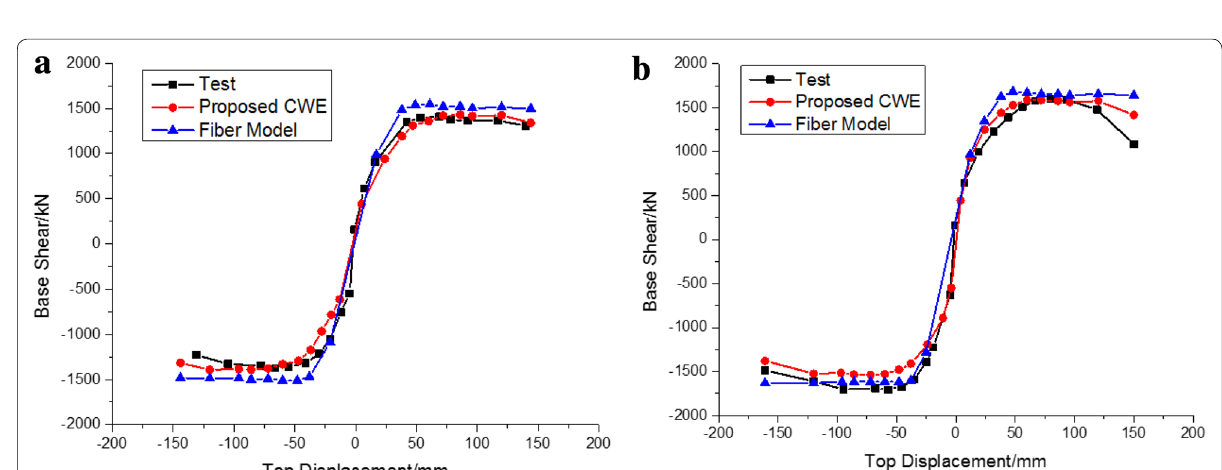
Fig. 16 Comparisons in backbone curves obtained from experimental data, proposed CWE model, and fiber model: a CW-1 and b